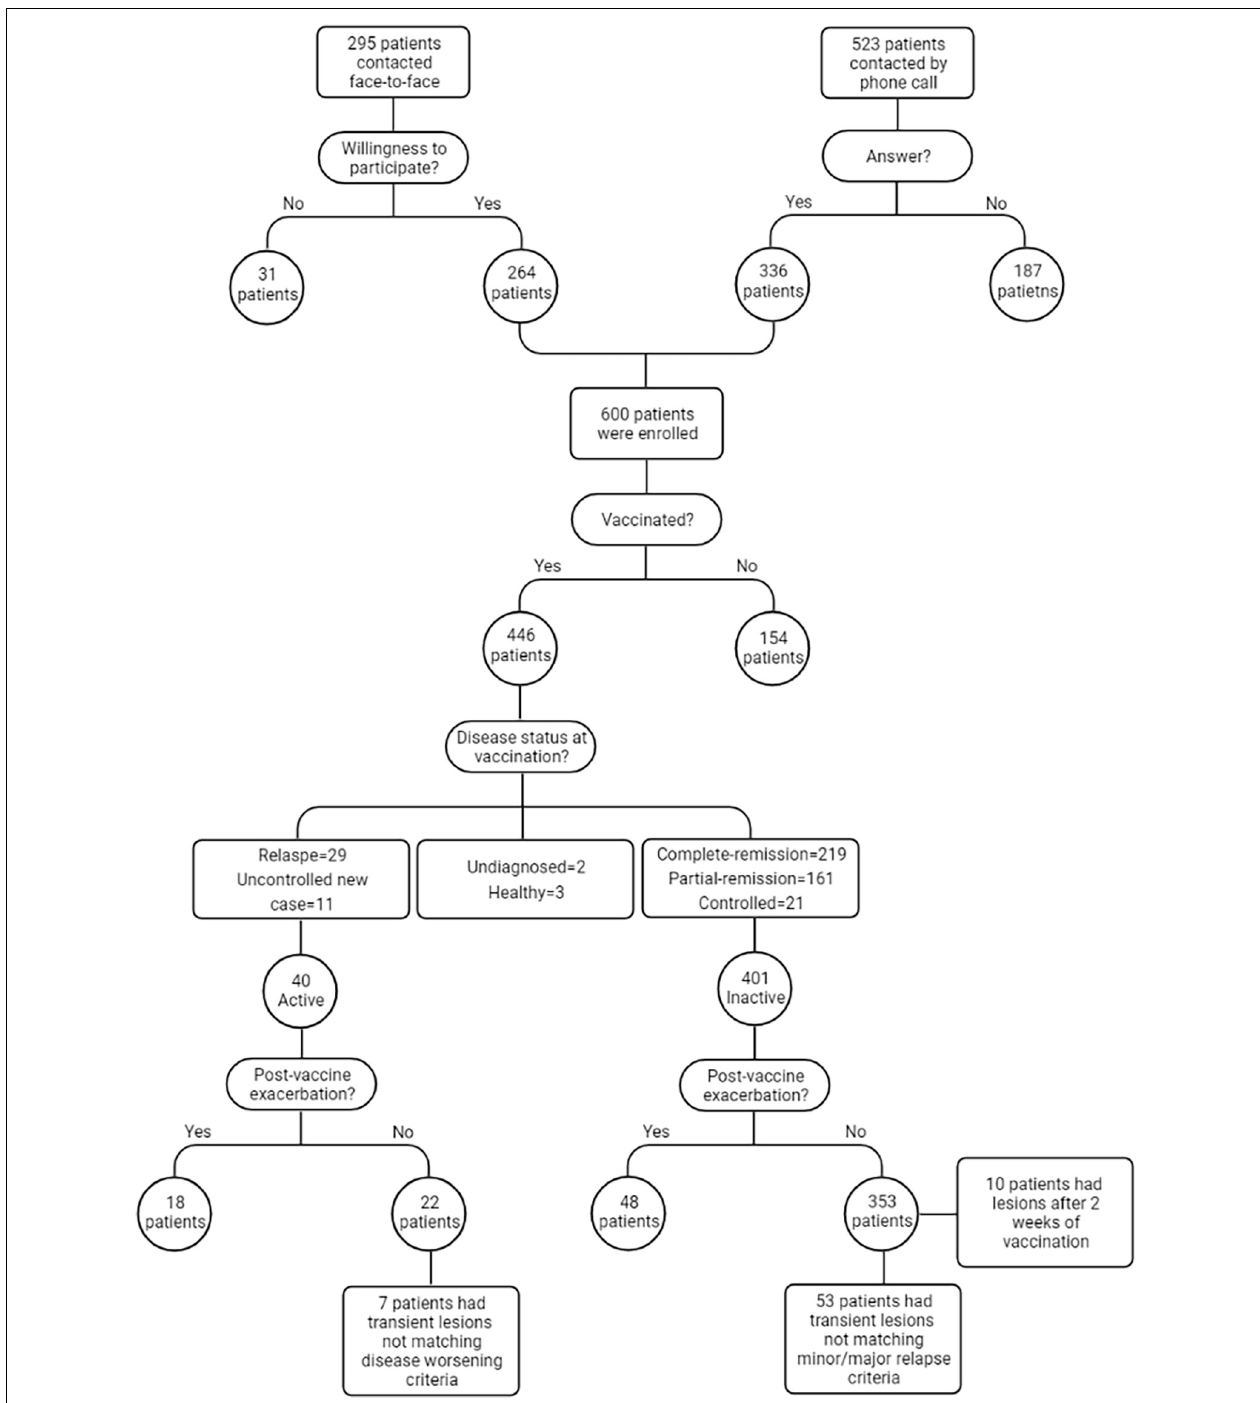
FIGURE 1 | Methodology of the